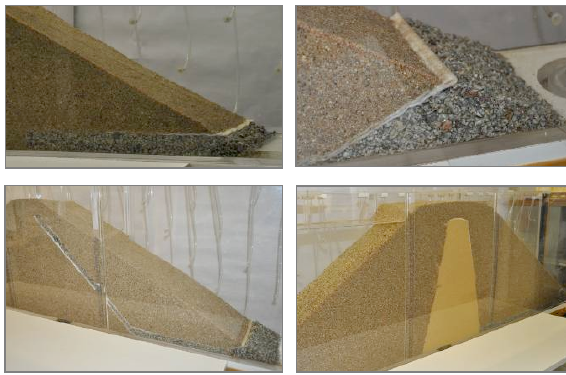
Figure 4. Drainage blanket, toe drain, clay core and chimney drain (clockwise from top left).